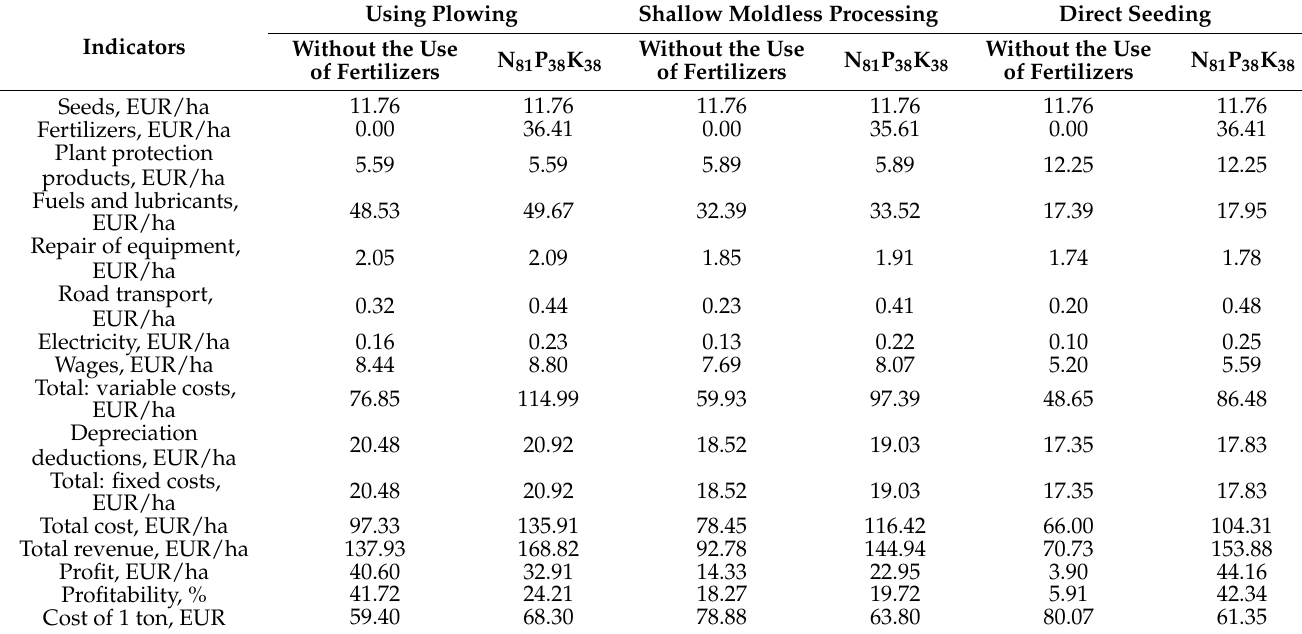
Table 10. Comparative economic efficiency of technologies for cultivation of spring